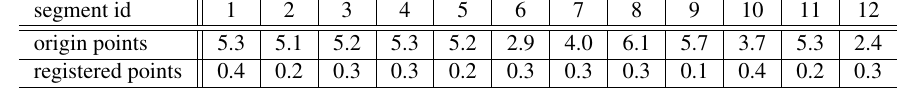
Table 3. Overview of the median distance [m] between the point cloud and the according building model per segment, after and before the registration.